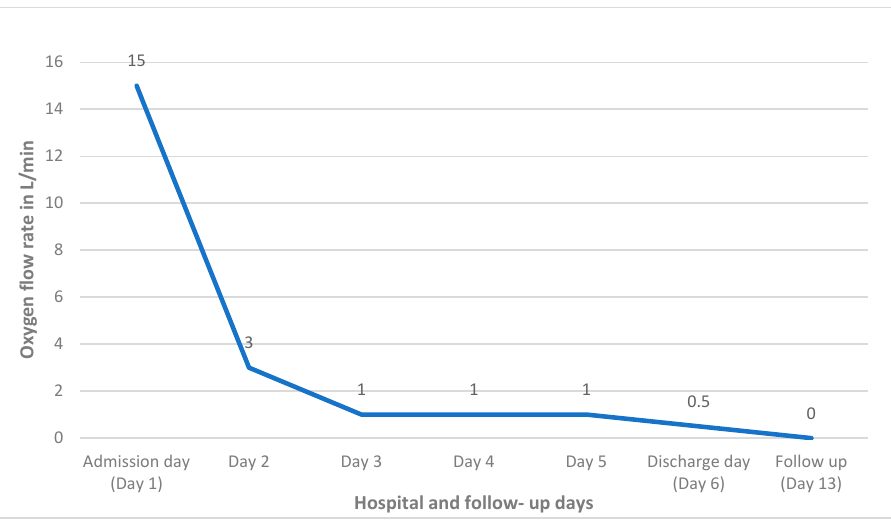
Figure 2. The trend of oxygen requirement during the hospitalization and follow-up.